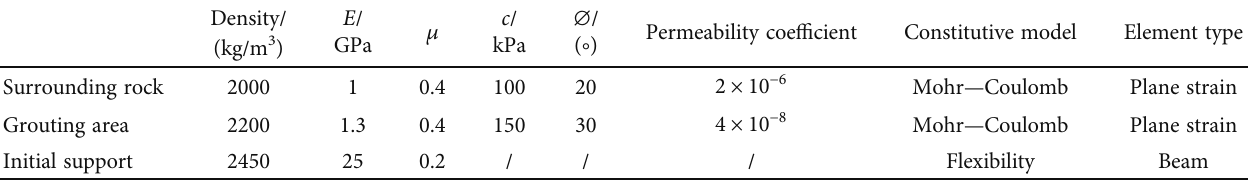
Figure 6: The model diagram of the thickness of the grout: (a) no grouting, (b) grout 1m, (c) grout 3m, (d) grout 5m, (e) grout 7m, and (f) grout 9m. Table 2: Material